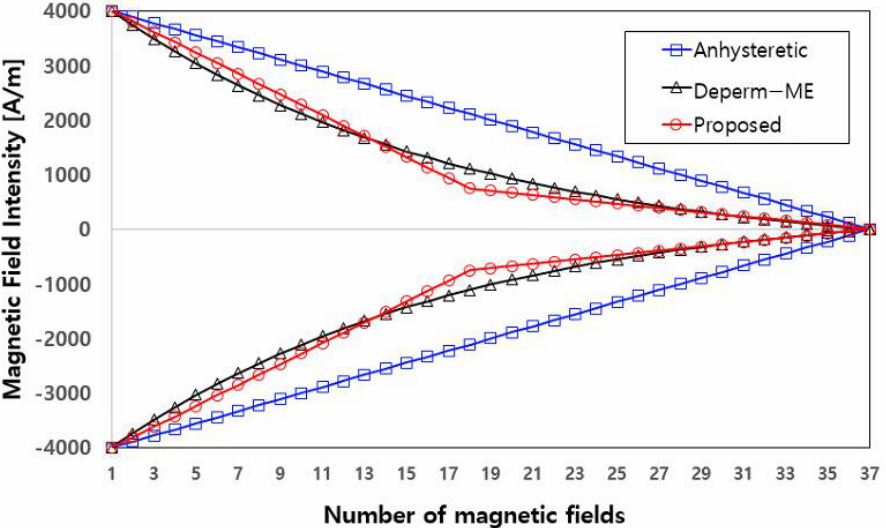
Figure 10. Three types of deperming protocols.